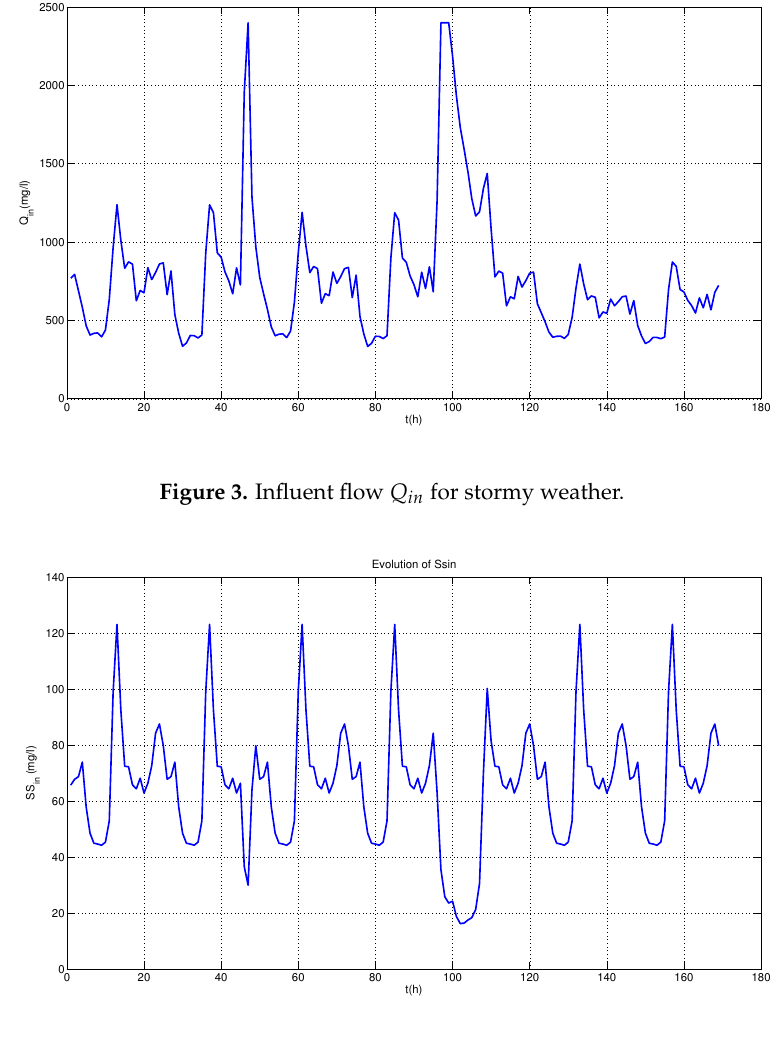
for stormy weather. in